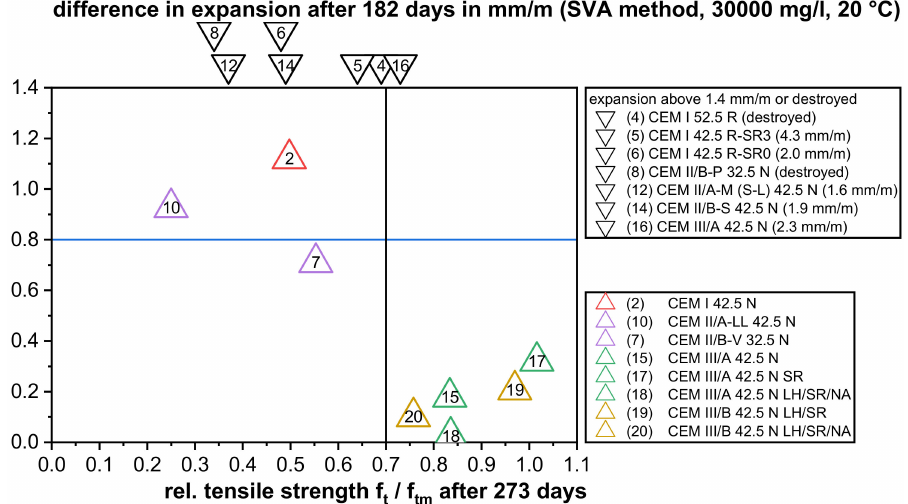
Figure 7. Difference in expansion (SVA method, 30,000 mg SO 4 2 − /L, 20 ◦ C) after 182 days over the relative tensile strength f t /f tm after 273